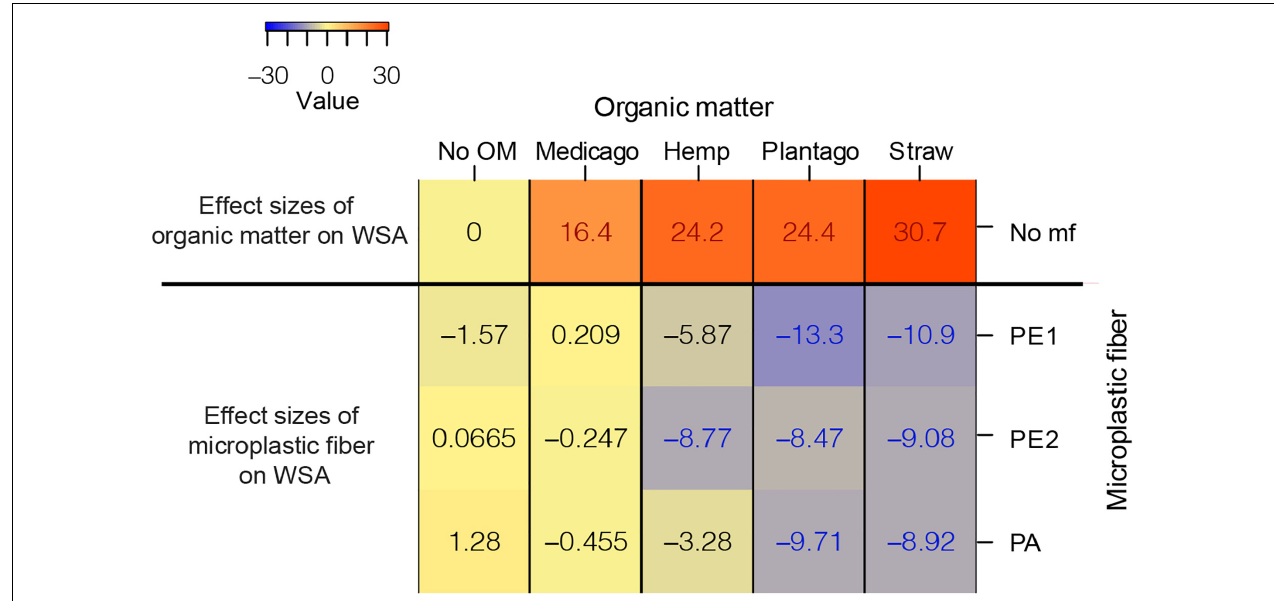
FIGURE 2 | The heatmap of the effect sizes of microplastic fiber and organic matter on WSA. The effect sizes of organic matter on WSA were the unpaired mean differences of organic matter addition alone and control (WSA organic matter – WSA No OM ). The effect sizes of microplastic fiber are the unpaired mean differences of the microplastic fiber addition and control with the addition of the different types of organic matter. (WSA organic matter_microplastic fiber – WSA organic matter_Nomf ) The blue text represents the statistically significant negative effect of microplastic fiber on WSA, the red text represents the statistically significant positive effect on WSA. “No OM” represents no organic matter addition, “No mf” represents no microplastic fiber